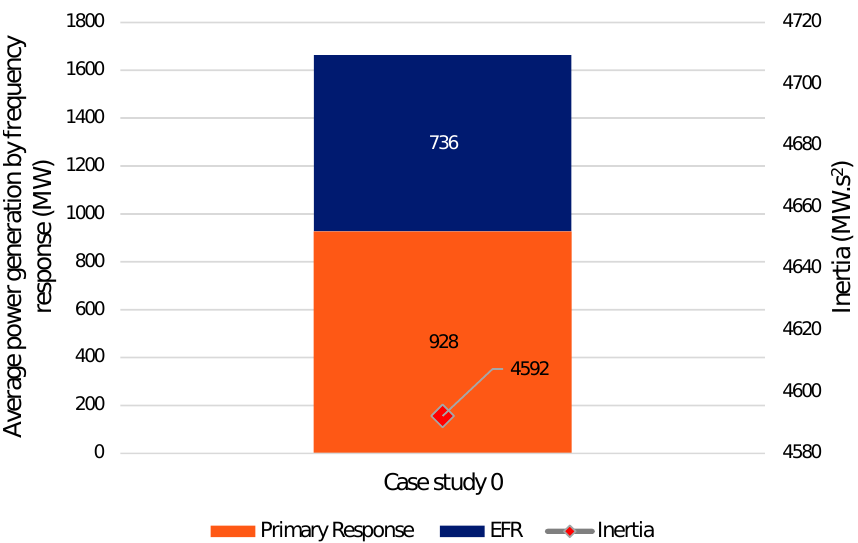
Figure 4. Average hourly frequency response requirement and inertia for Case study 0.